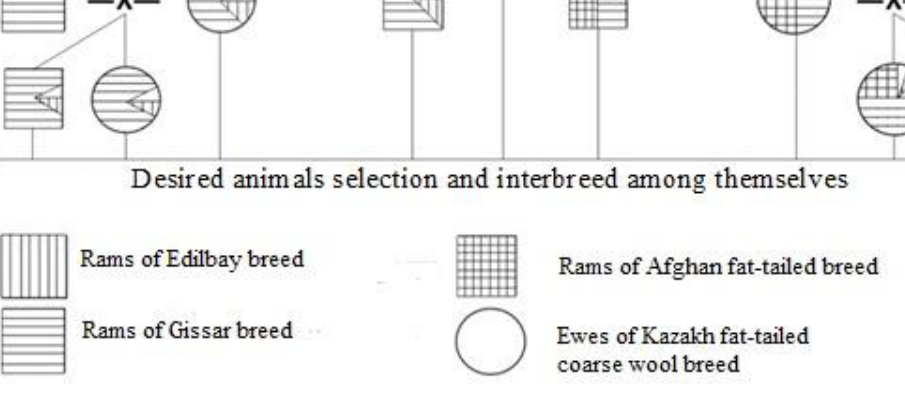
Figure 1. Breeding scheme for the Baisary breed of meat-fat sheep with improved productivity.